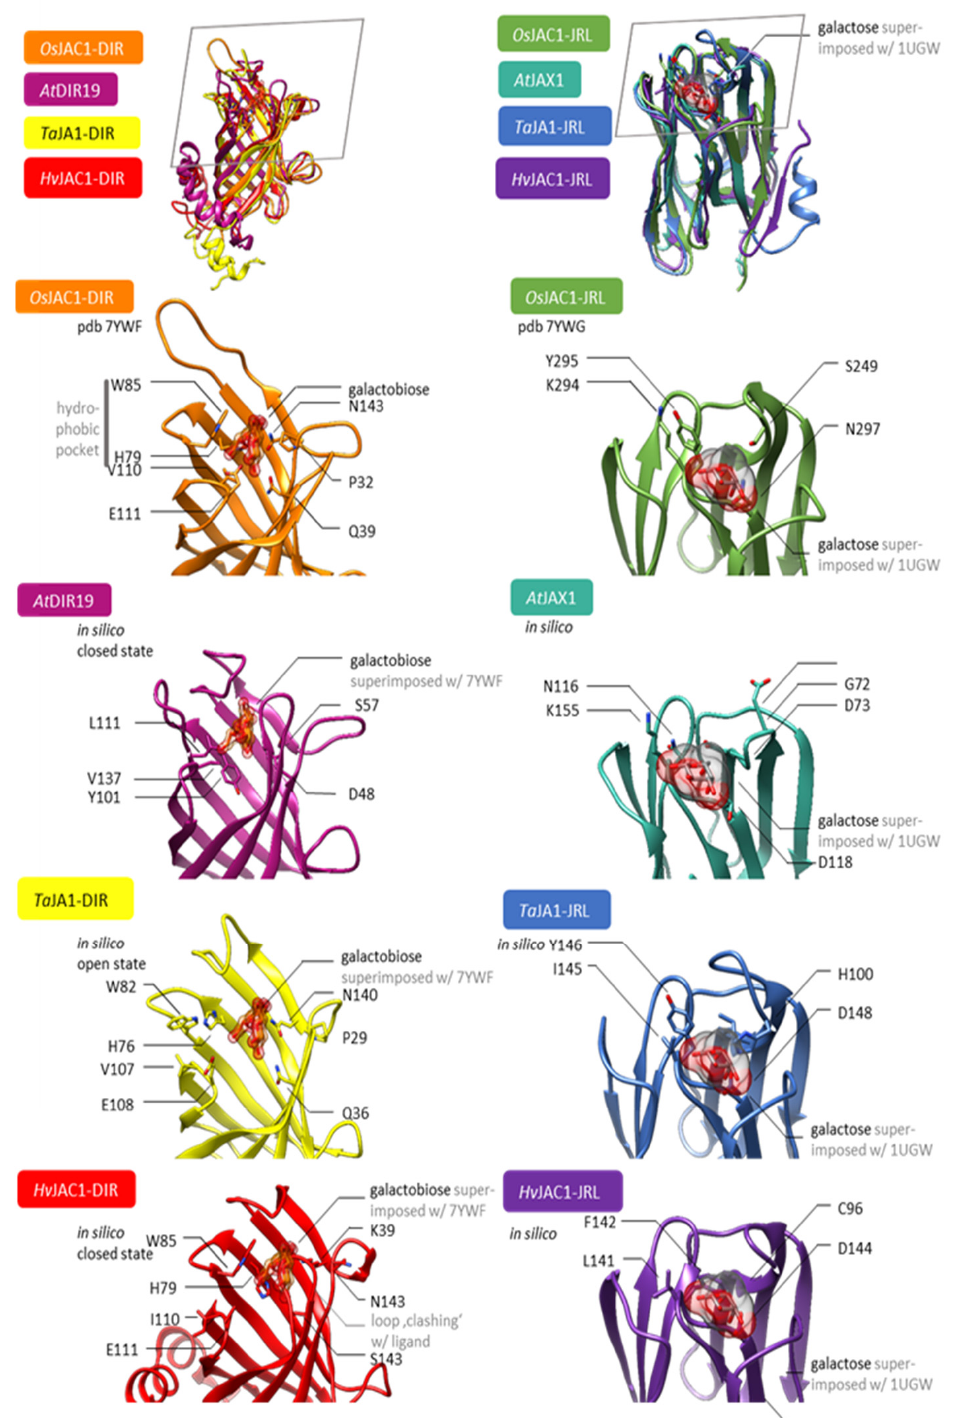
Figure 7. Structural models of selected DIR and JRL domains. Left column from top to bottom: Superposition of molecular models of Os JAC1-DIR [orange, from pdb 7YWF [23]], Ta JA1-DIR [yellow], At DIR19 [light purple], and Hv JAC1-DIR [red]. The ligand galactobiose is superimposed from OsJAC1-DIR to illustrate the putative binding site. Right column from top to bottom: Superposition of molecular models of Os JAC1-JRL [green, from pdb 7YWG], Ta JA1-JRL [blue], At JAX1 [turquoise], and Hv JAC1-JRL [purple]. The ligand is a superposition of galactose from pdb 1UGW [24]. The grey frame in the top row illustrates the selected perspective of the close-ups. The models for Ta JA1-DIR, Hv JAC1-DIR, At DIR19, Ta JA1-JRL, At JAX1, and Hv JAC1-JRL have been generated using TopModel.